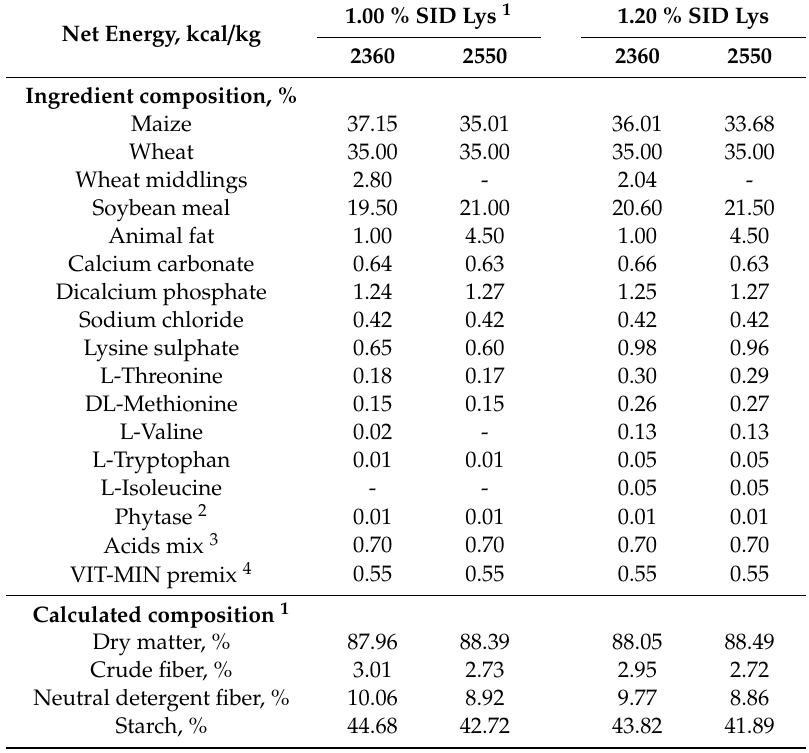
Table 1. Ingredient, calculated and analyzed composition (as fed basis) of the feeds used in Experiment